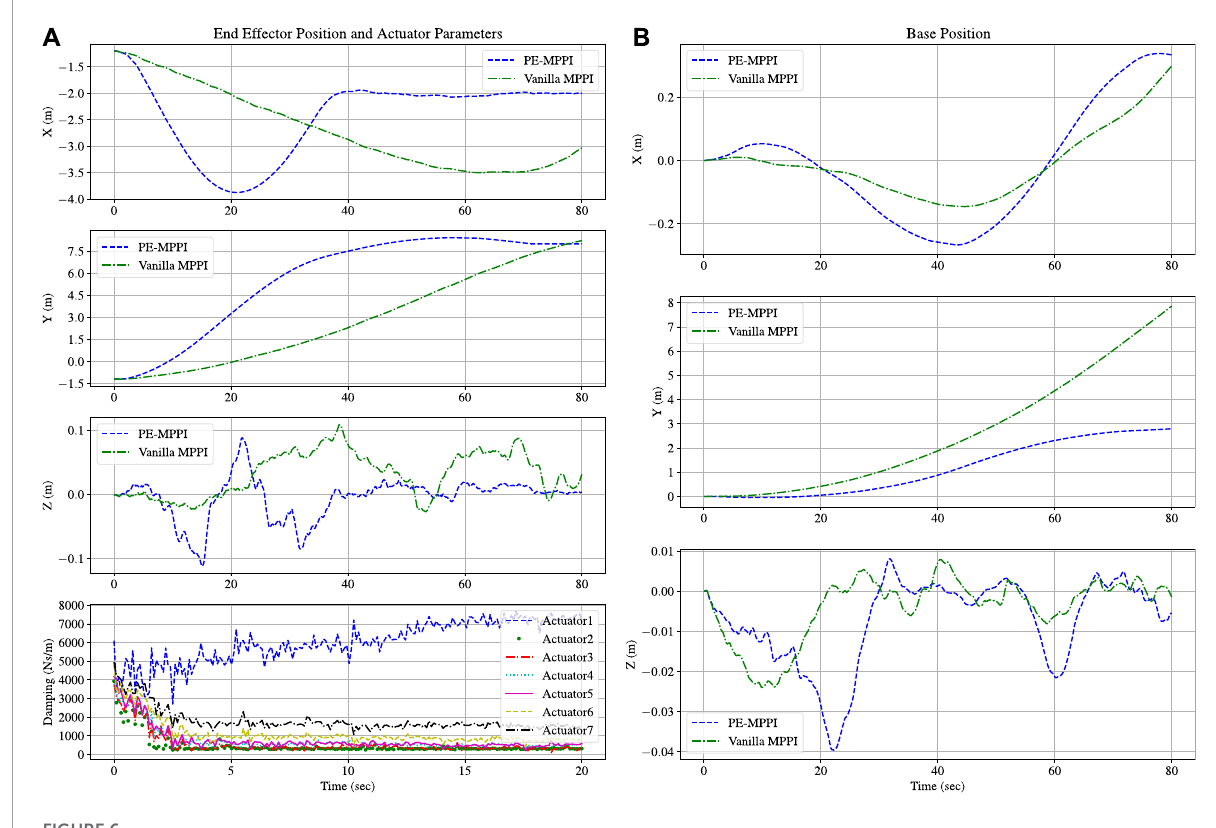
FIGURE 6 System identification scenario; Comparison between PE-MPPI and vanilla MPPI for the end-effector position (A; Top) . Convergence of the parameters of the on-board model to real system (A; Bottom) . Comparison between PE-MPPI and vanilla MPPI for the space robot base position (B)